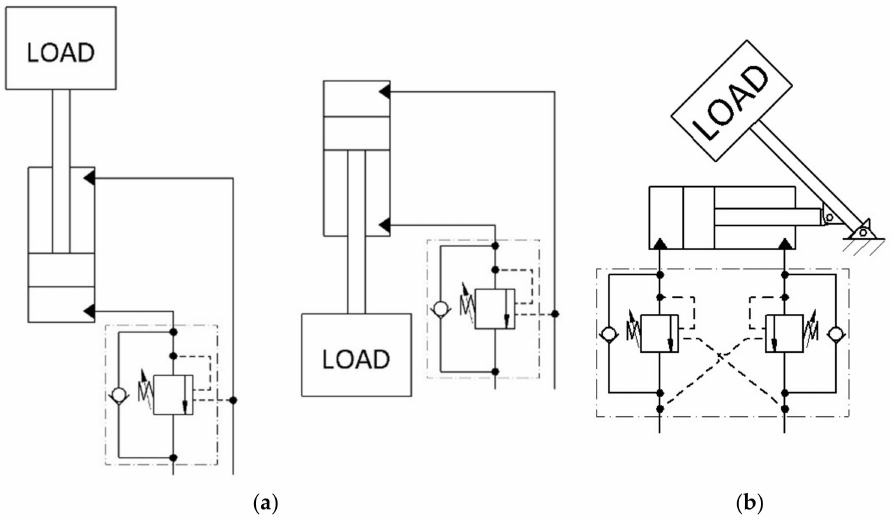
Figure 13. Counterbalance valve application: ( a ) active load; ( b ) variable load.